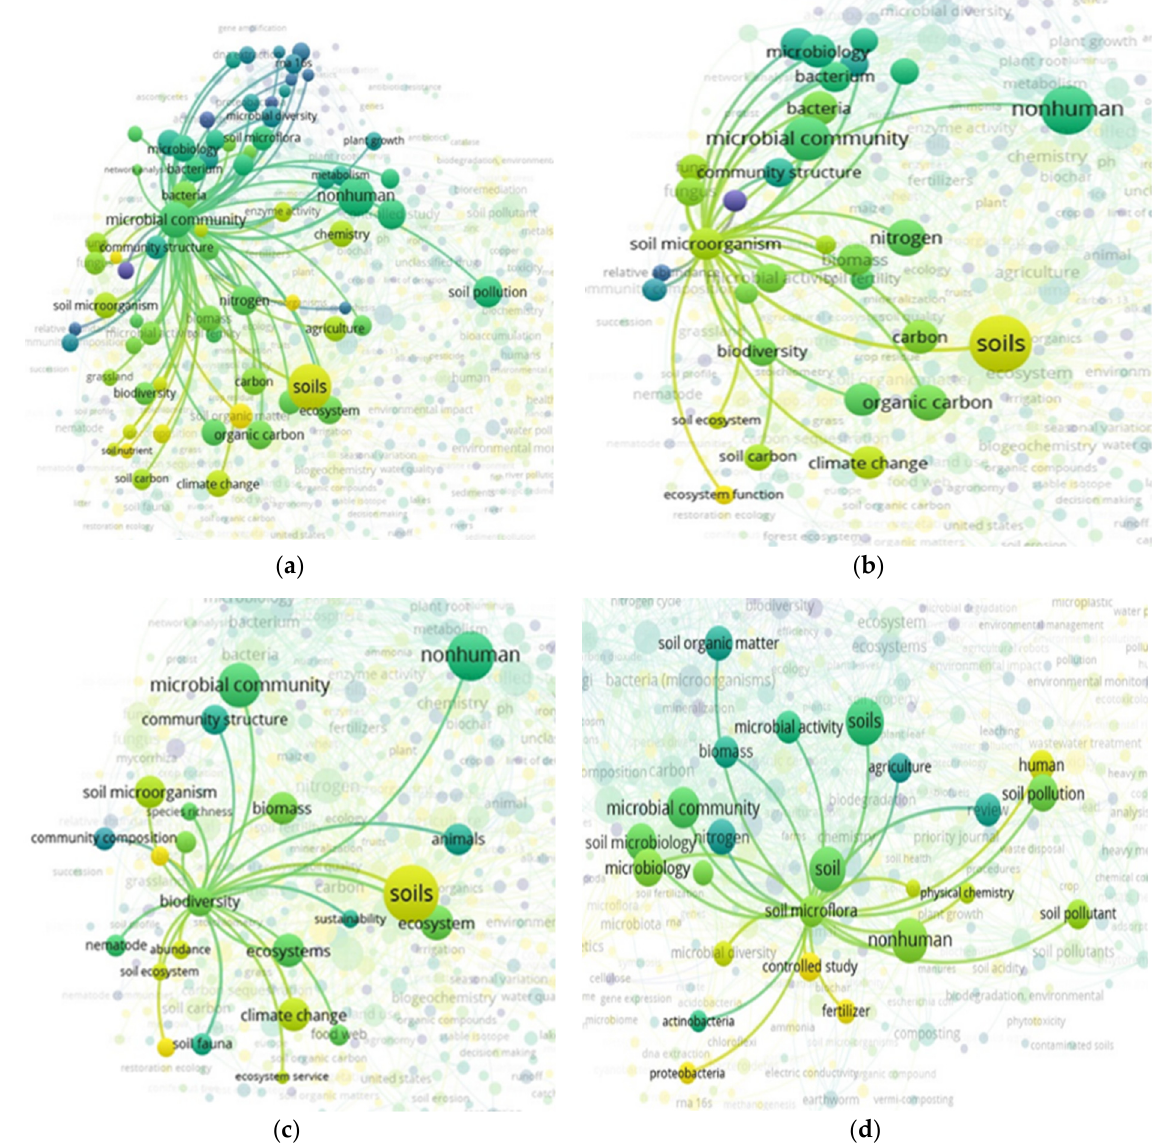
Figure 6. Analyzing Scopus results with the VOSviewer. The microbial community ( a ); soil microorganisms ( b ); the biodiversity ( c ); and ( d ) the soil microflora paradigm.